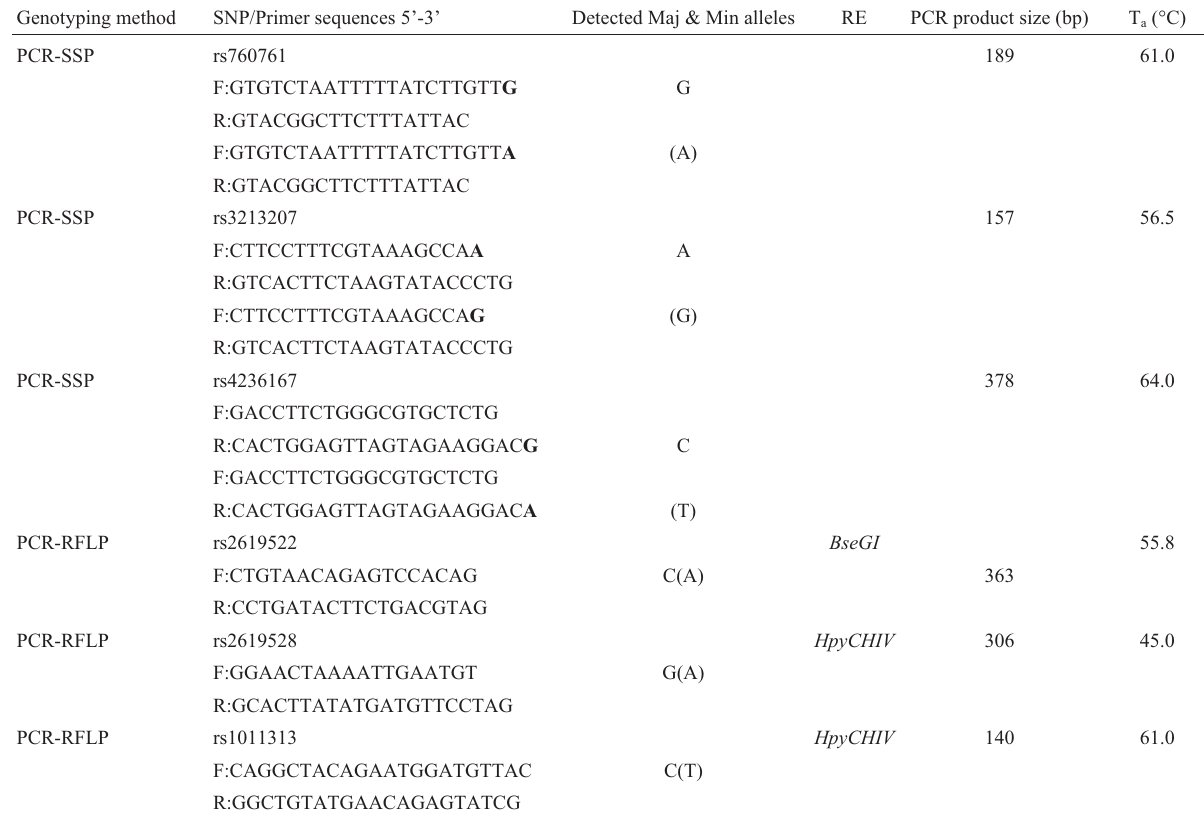
Table 2 - The SNP primer sequences, detected alleles for PCR-SSP, restriction enzyme, and PCR product